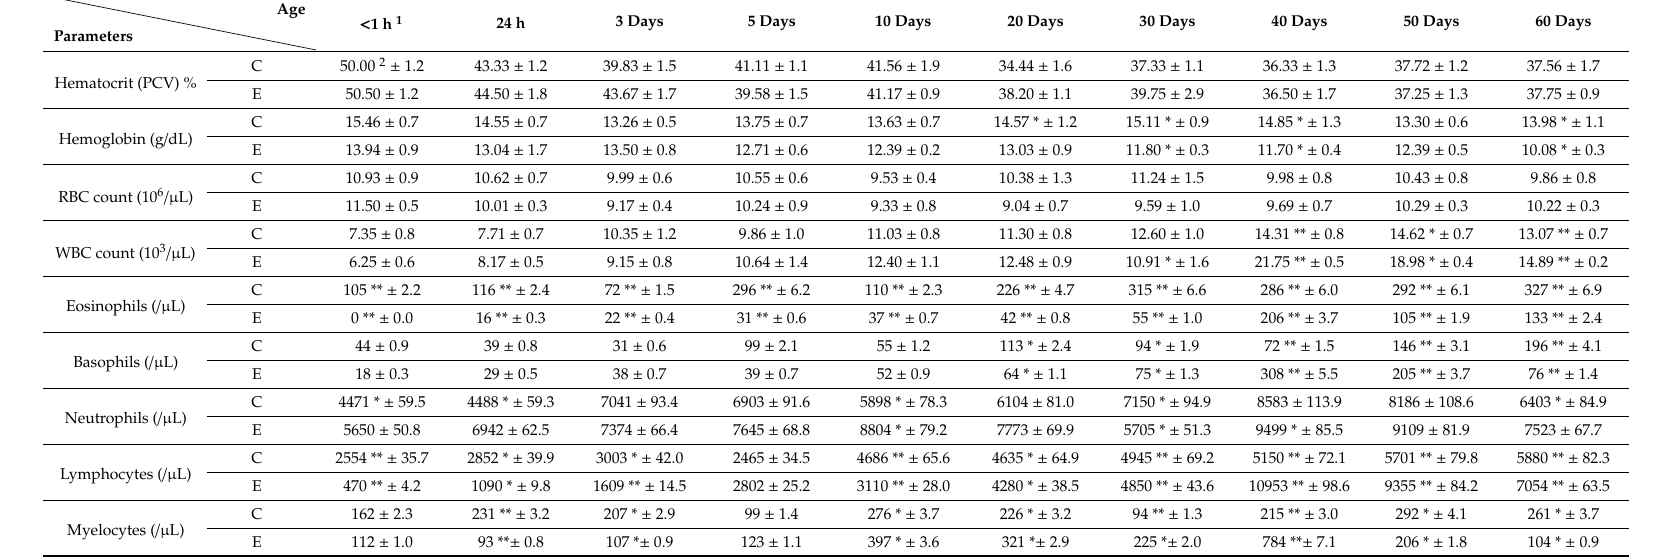
Table 5. Level of blood morphotic elements in foals (mean ±